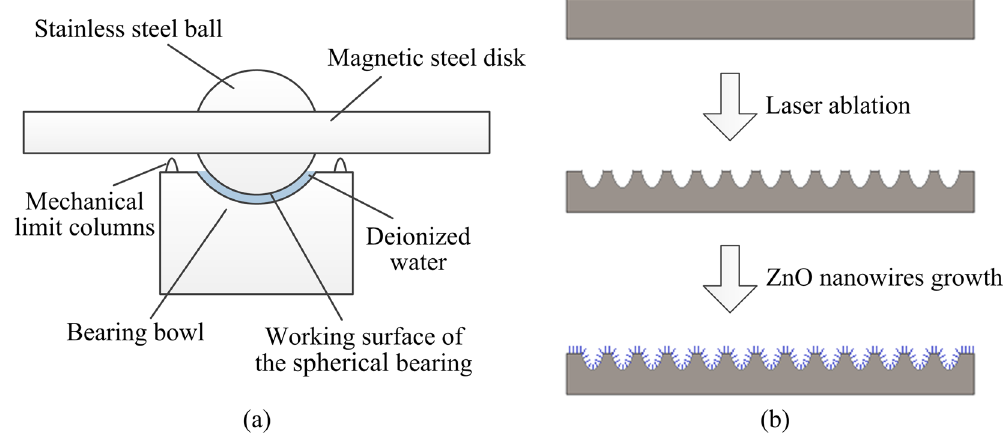
Figure 1. ( a ) The structure of the spherical bearing showing the working surface. ( b ) The fabricating method of the micron-nano composite structures.